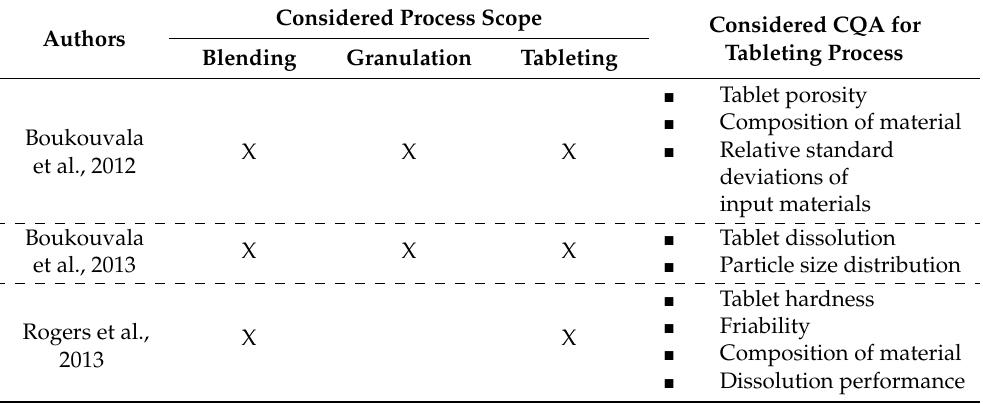
Table 1. Dynamic FSS modeling and simulation approaches to pharmaceutical